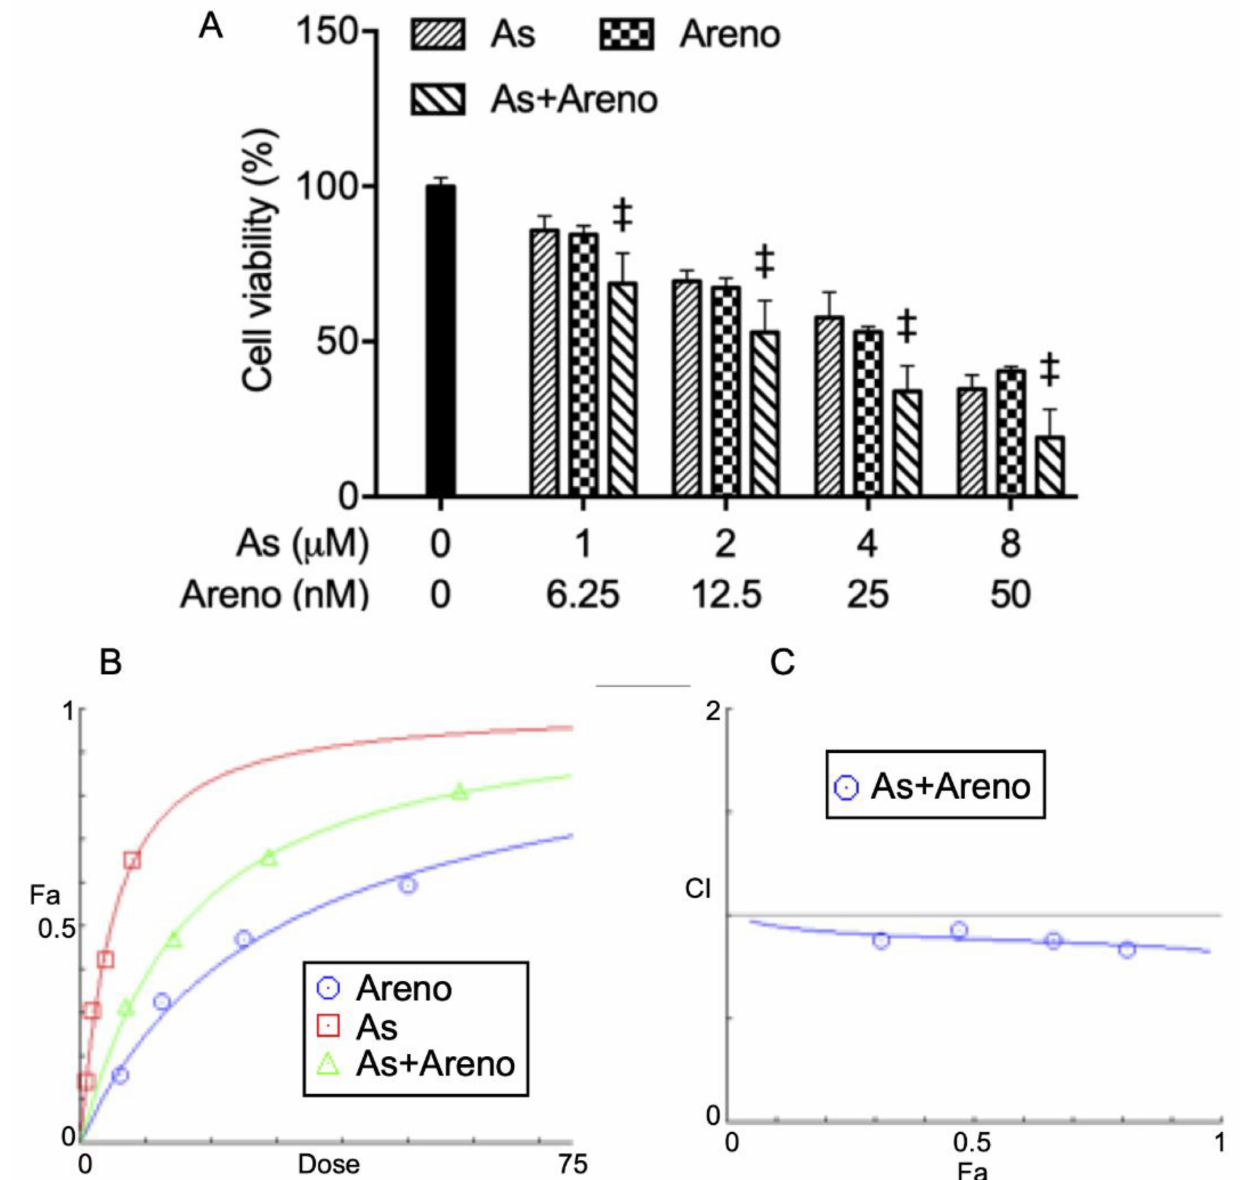
Figure 2. Synergistic cytotoxic effect of As III and arenobufagin in U-87 cells. ( A ) U-87 cells were treated with the combination of As III and arenobufagin at a constant ratio (1 µ M As III + 6.25 nM